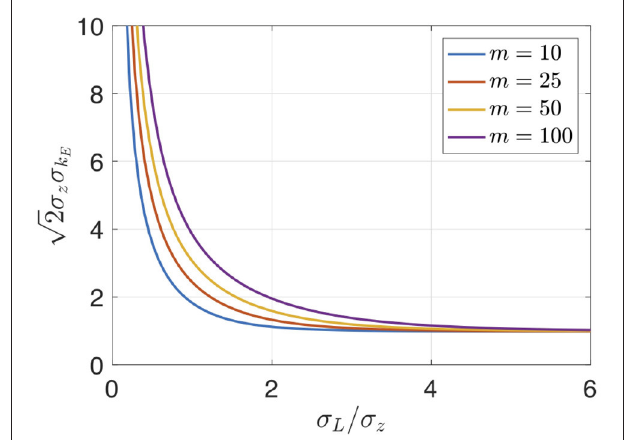
FIGURE 2 | Normalized RMS and FWHM lengths of the bunching envelope from exact numerical calculations (solid lines) and from the super-Gaussian approximation (dashed lines).